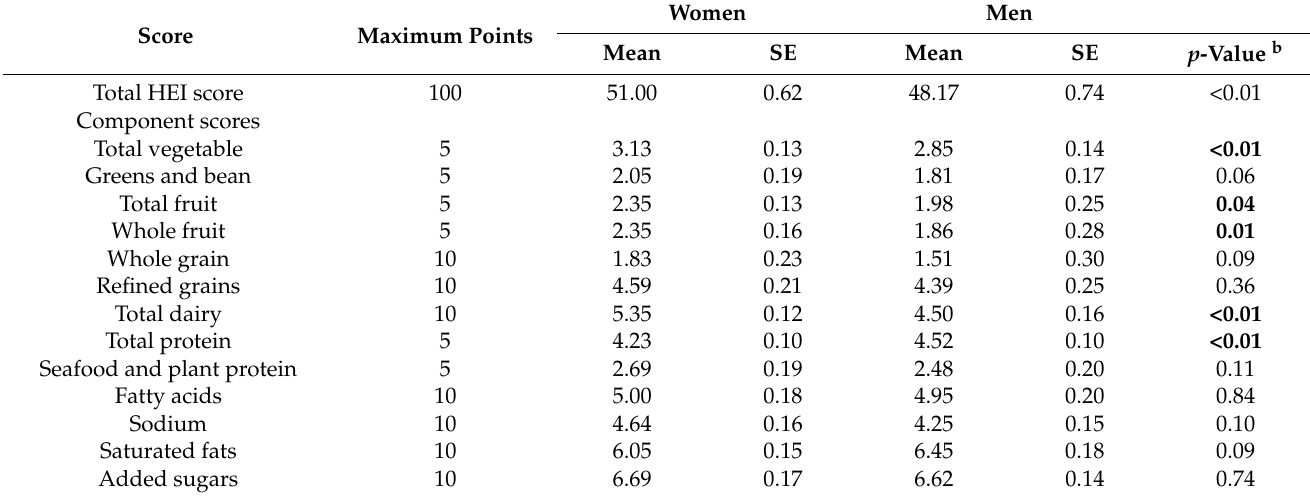
Table 3. Healthy eating index 2015: Total HEI (Healthy Eating Index) score and component scores for women and men a . Women Men Score Maximum Points Mean SE